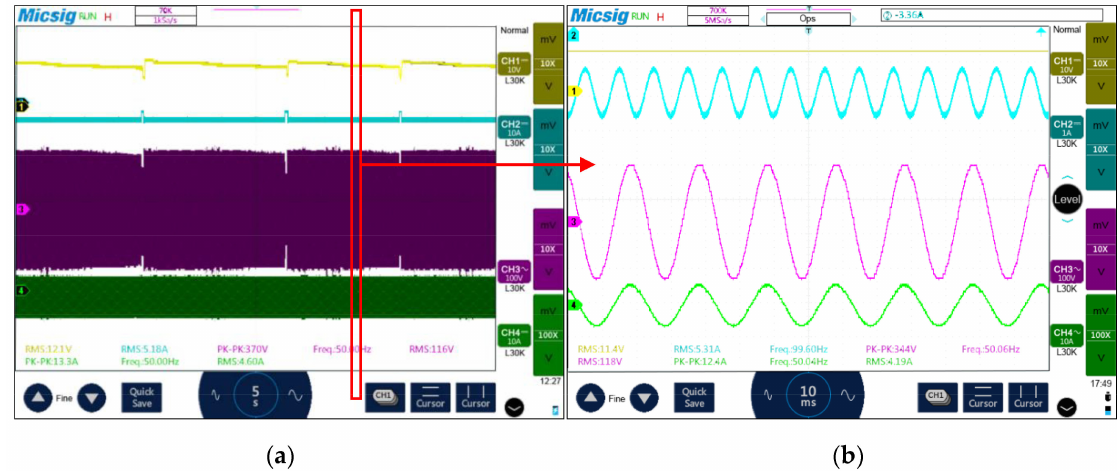
Figure 9. The input/output waveforms of the SCAWI-PV inverter operating at 100W output load (Yellow—Input DC voltage, Blue—Input current, Purple—Output AC voltage, Green—Output current): ( a ) For waveform—duration =5 s; ( b ) For waveform duration =10 ms.